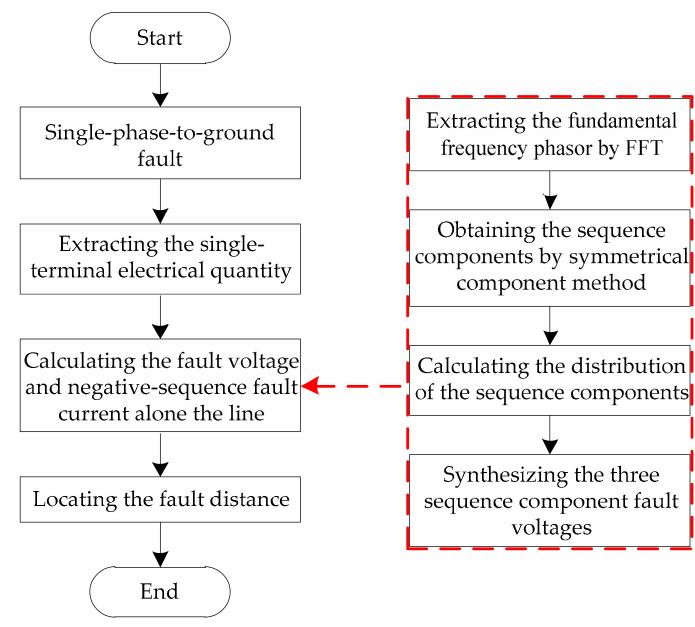
Figure 5. Overall flowchart of the proposed fault location